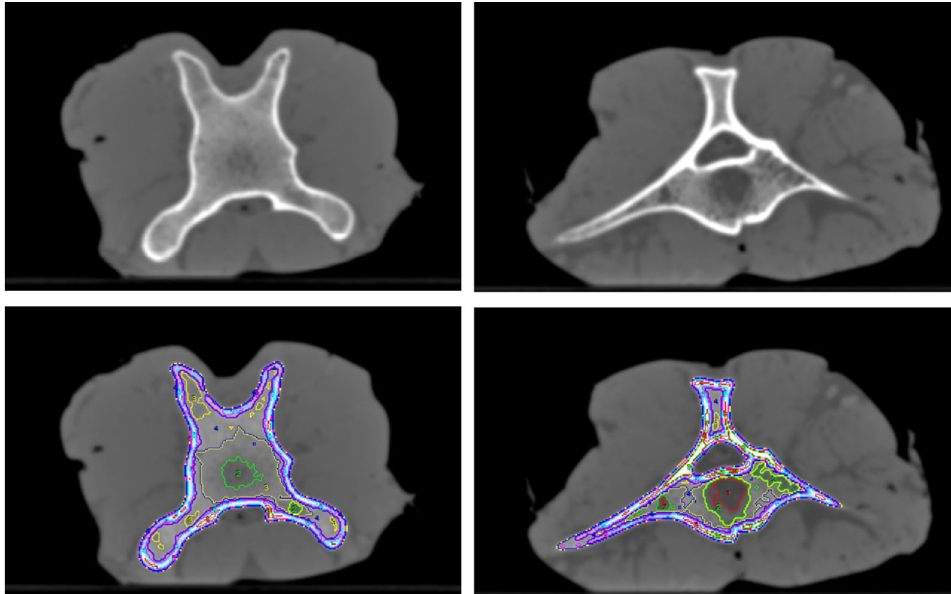
Figure 7. Segmentation of areas with different bone densities using thresholding on the 120 kV image volumes. Example shows two slices from bovine vertebral bodies in the oxtail sample. Upper row: CT image, lower row: CT slice with regions of interest defining the bone density segments.